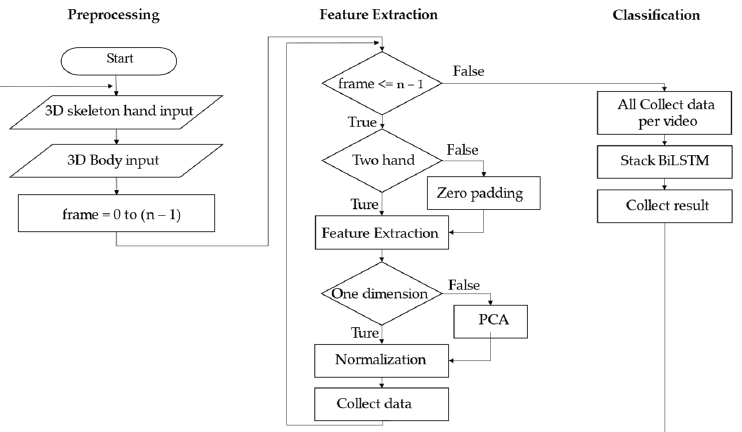
Figure 7. Flowchart of the proposed method.